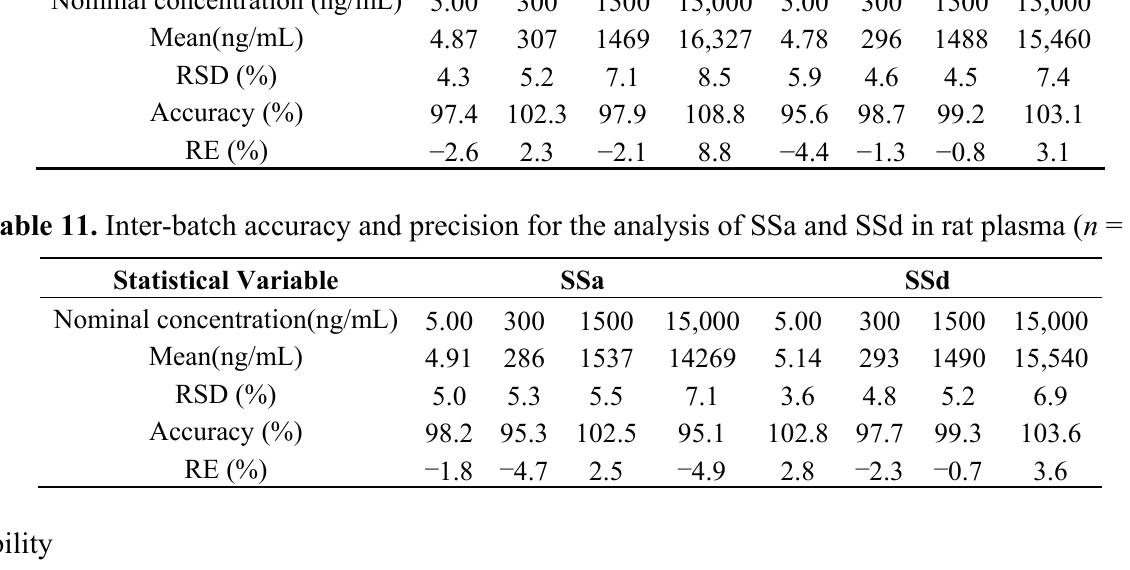
Table 10. Intra-batch accuracy and precision for the analysis of SSa and SSd in rat plasma ( n = 5). Statistical Variable Nominal concentration (ng/mL)